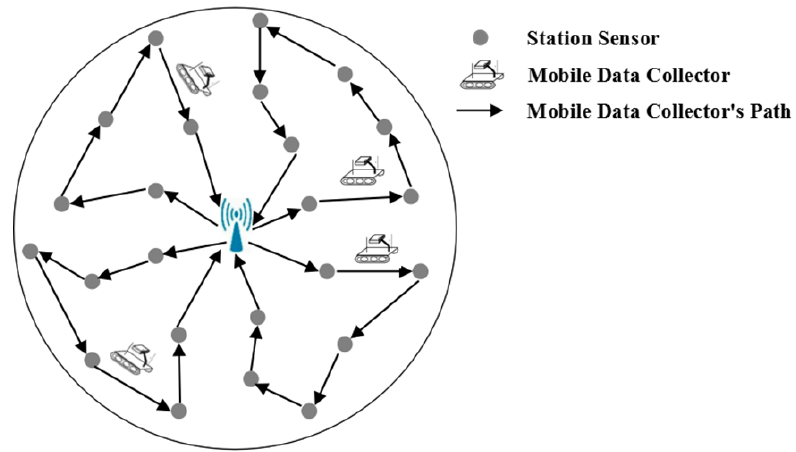
Figure 12. Network partition strategy of DCEM [30].